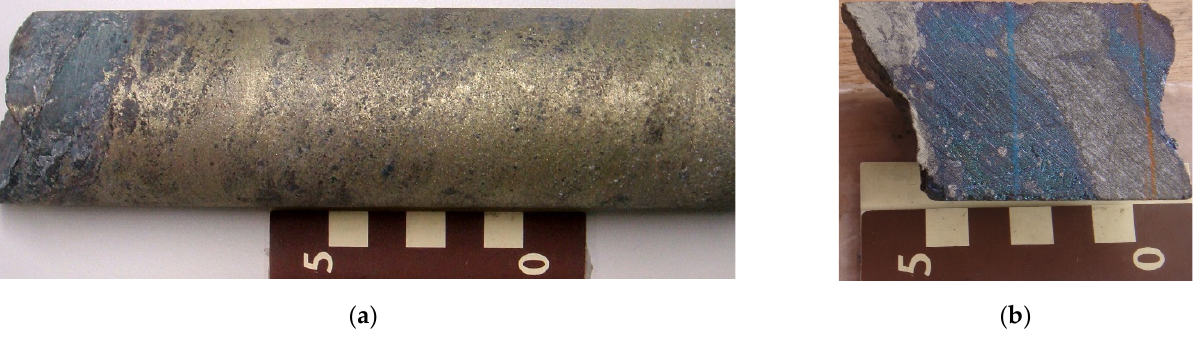
Figure 5. Photographs of ore samples. Scale in centimeters. ( a ) Chalcopyrite and ( b ) bornite dominant veins and breccias with an amphibole-magnetite hydrothermal assemblage.